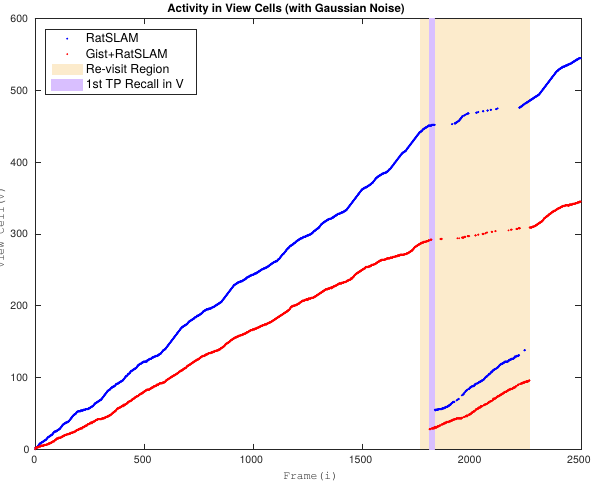
Figure 5: Activity in view cells when Gaussian noise is added to every frame. Gist+RatSLAM is able to detect a loop closure before RatSLAM and shows relatively good convergence.